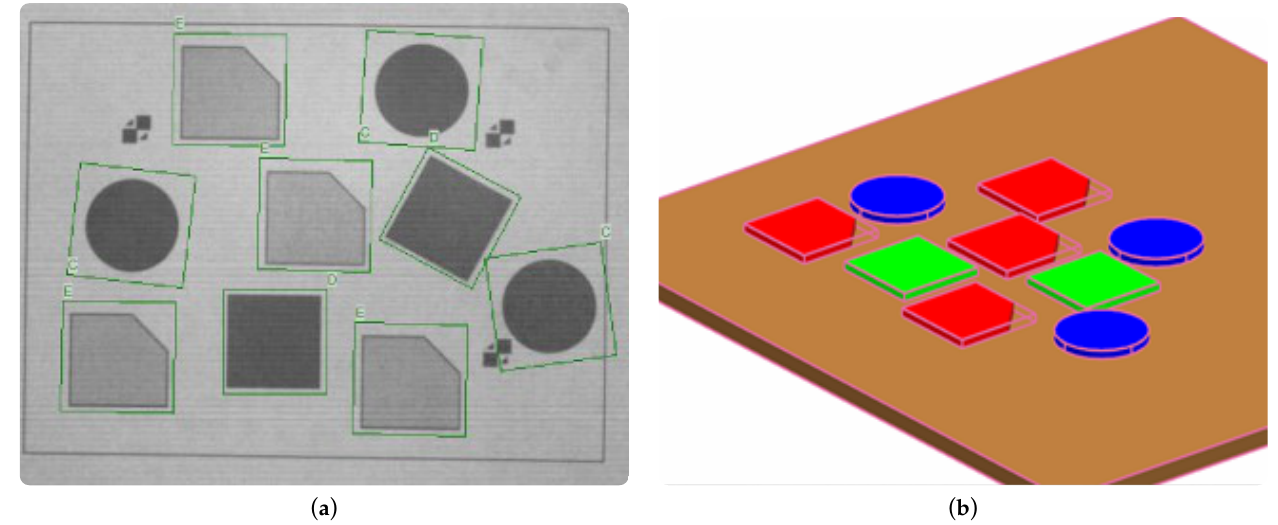
Figure 6. Object recognition using smart camera. ( a ) Detection of parts. ( b ) Visualization of detected parts in NX